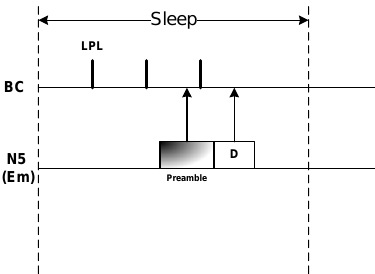
Figure 11. Emergency data transmission during the SLEEP